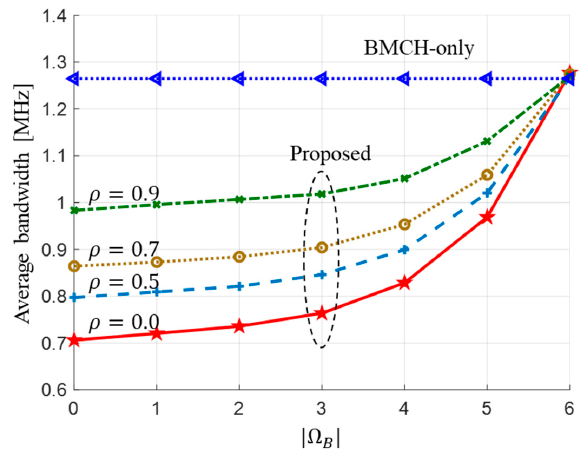
Figure 5. Average bandwidth comparison with correlated Rayleigh fading.